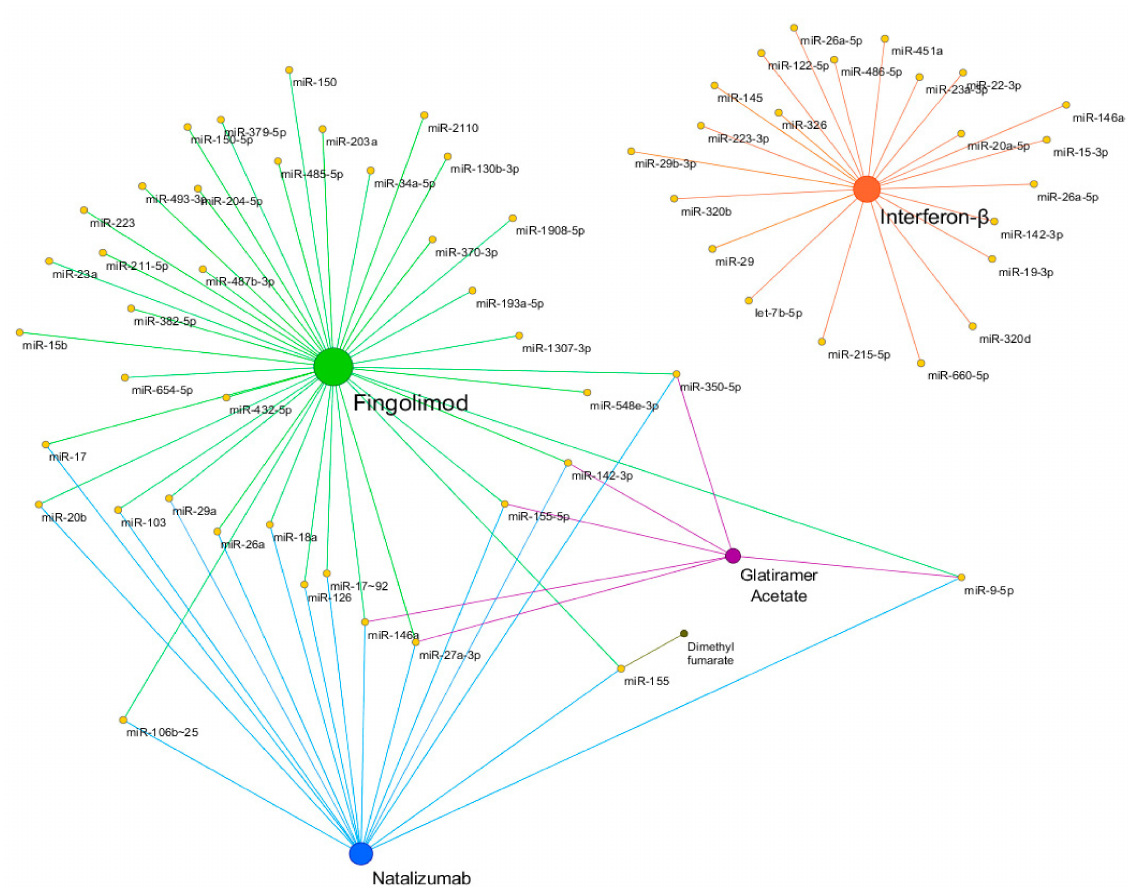
Figure 2. Schematic representation of miRNA pharmacoepigenomics reported in MS by Cytoscape v3.7.1. Yellow nodes represent miRNAs. Fingolimod, Natalizumab, Glatiramer Acetate, Interferon- β , and Dimethyl fumarate, are shown in green, blue, purple, orange, and brown, respectively. The size of the nodes is proportional to the degree of the nodes. It is worthy to mention that, among the more frequently used disease-modifying therapies (DMTs) in relapsing-remitting course (RRMS), Fingolimod, Glutiramer Acetate, and Natalizumab seem to significantly impact the expression levels of common miRNAs (and possibly target genes), while their mechanisms of action are quite di ff erent (see the text). Indeed, this observation may su ff er from some biases due to e.g., the selection of the investigated miRNAs, the molecular methods used, etc., so more definitive conclusions can be drawn after planned